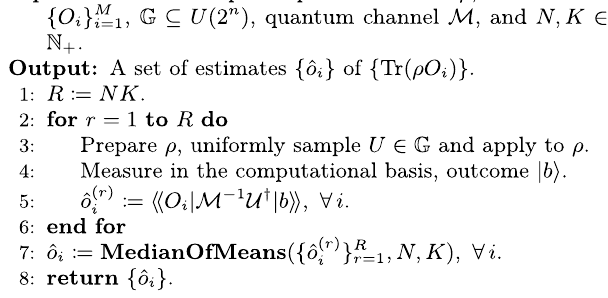
Algorithm 1. Shadow estimation ( Shadow )